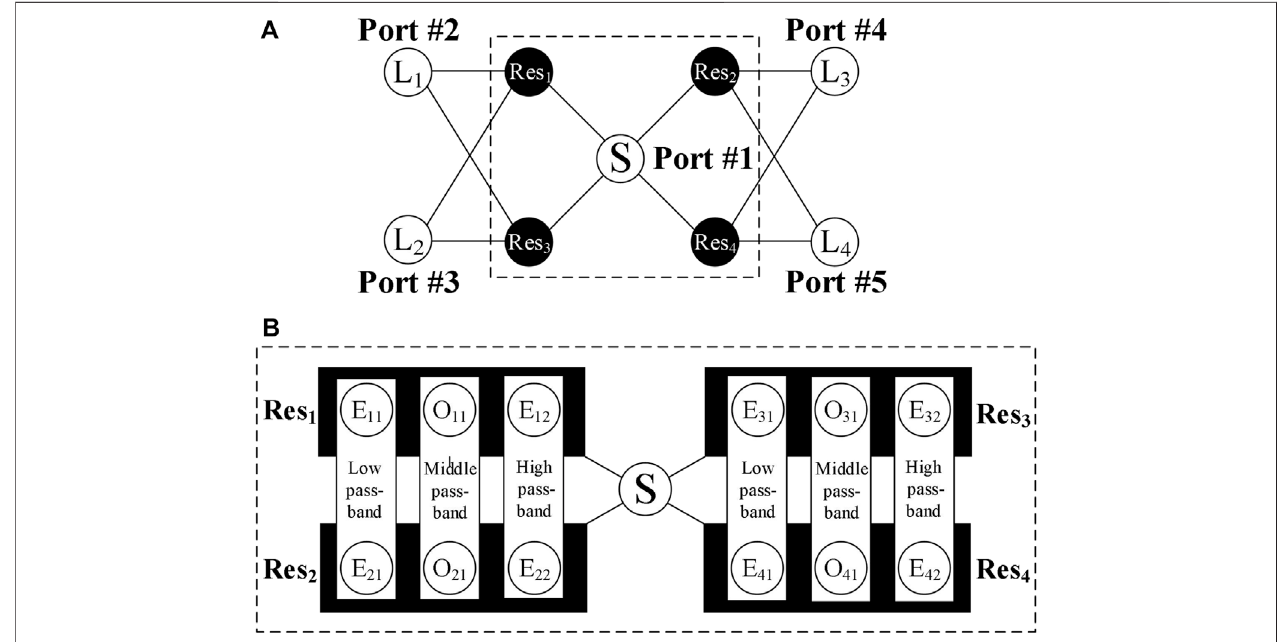
FIGURE 4 | The coupling topology and mode distribution. (A) The design coupling scheme of proposed FPD. (B) The modes consist of three passbands.